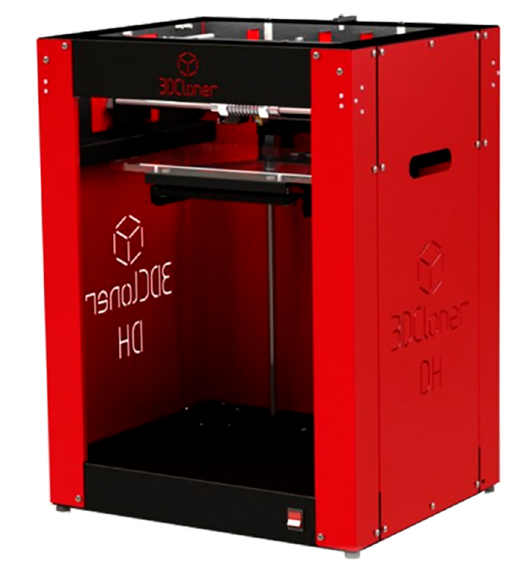
Figure 3. 3D Cloner DH Printer. Source: 3dcloner.com.br